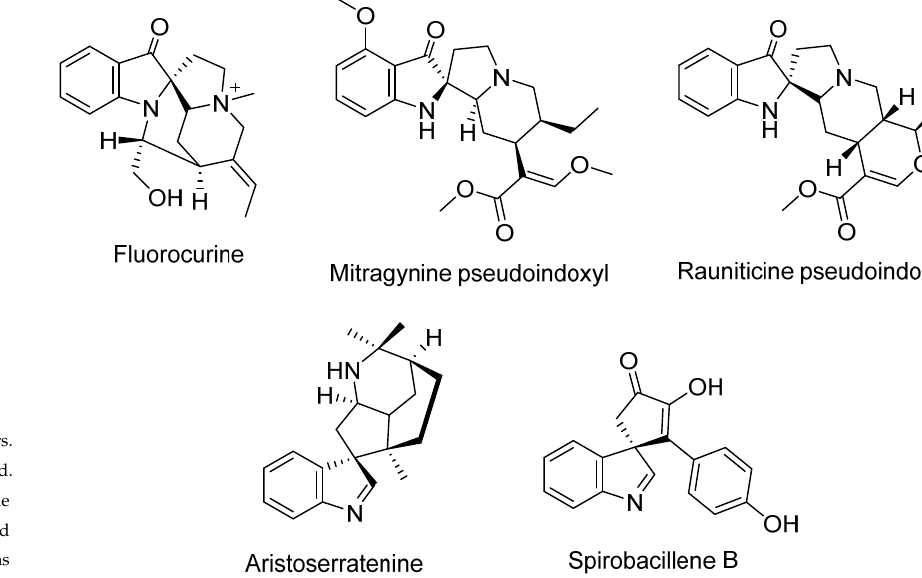
Figure 1. Natural C-2 and C-3 spiroindole-containing compounds.